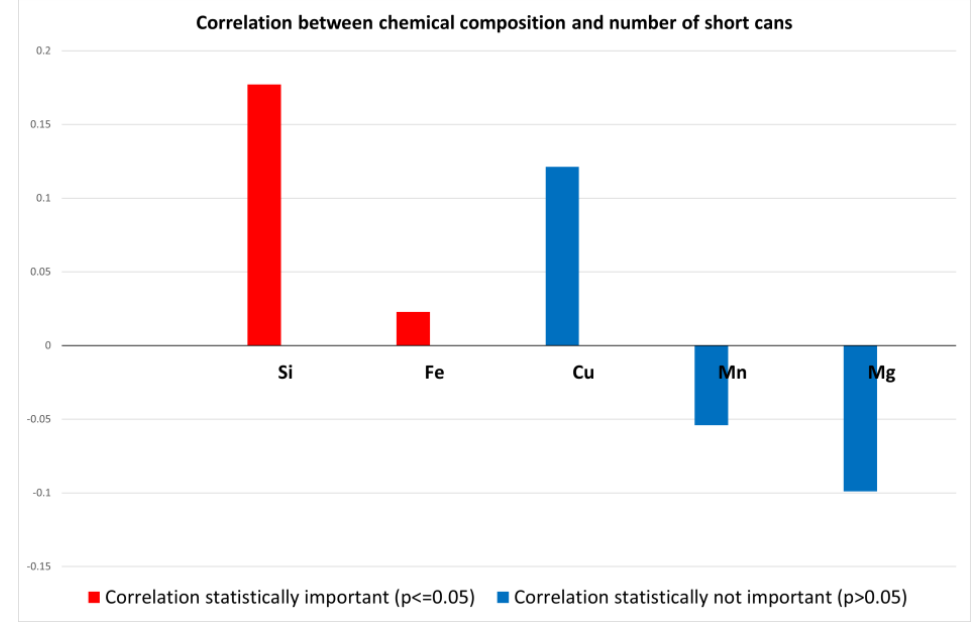
Figure 6. Correlation between chemical composition and number of short cans.